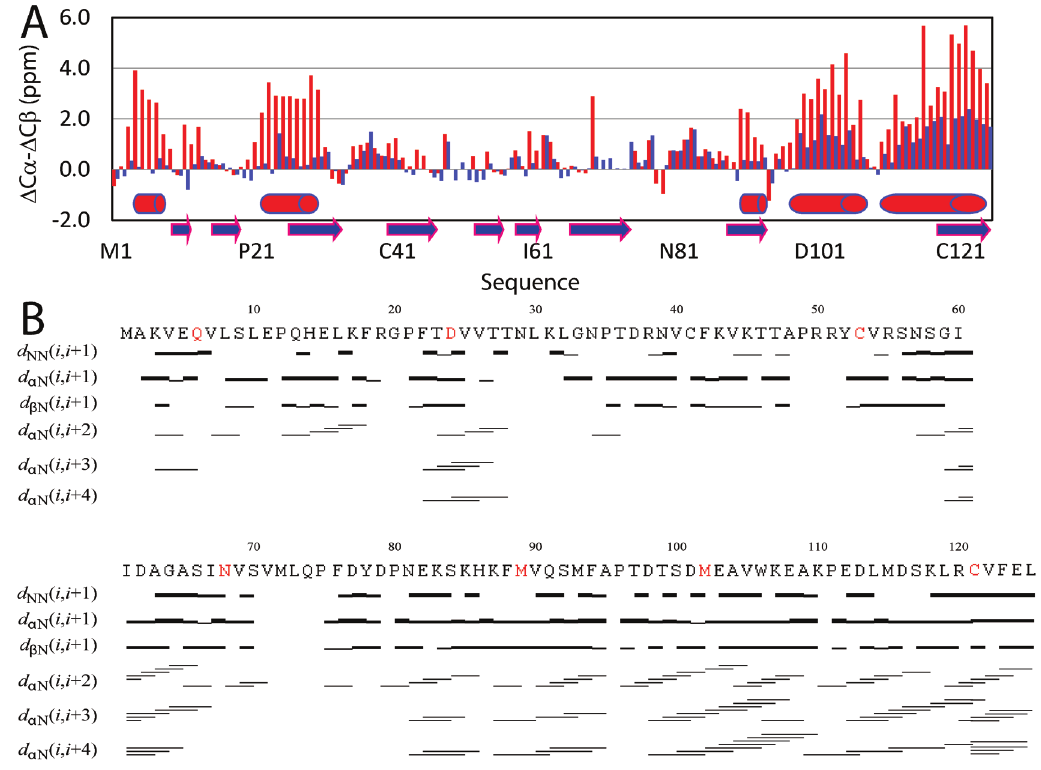
Figure 2. NMR evidence for well-formed helices of the P56S MSP upon partitioning into DPC micelles. A . Residue specific ( Δ C α - Δ C β ) values of the P56S MSP in aqueous solution (blue) and in DPC micelle (red). The blue arrows are used for indicating the β -strands in the wild- type MSP structures and red cylinders for helices formed in DPC micelles. B . NOE connectivities defining secondary structures of the P56S MSP in DPC micelle. The seven residues selected for spin-labeling are colored in